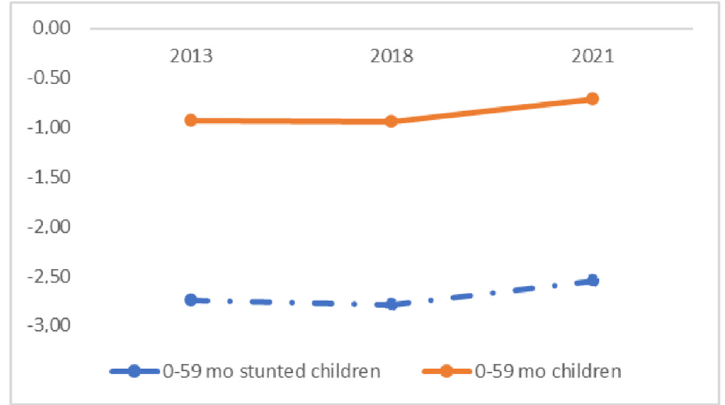
Figure 4. Trend of HAZ score among children and stunted children in Yogyakarta, 2013–2021. The average body length or height of male and female toddlers in 2021 increased compared to the previous study. Male and female toddlers aged <20 months had relatively the same body length as the WHO median. However, after >20 months, the heights of the male and female toddlers were lower than the WHO median. The height of the males was still higher than that of the females (Figure 5A,B).